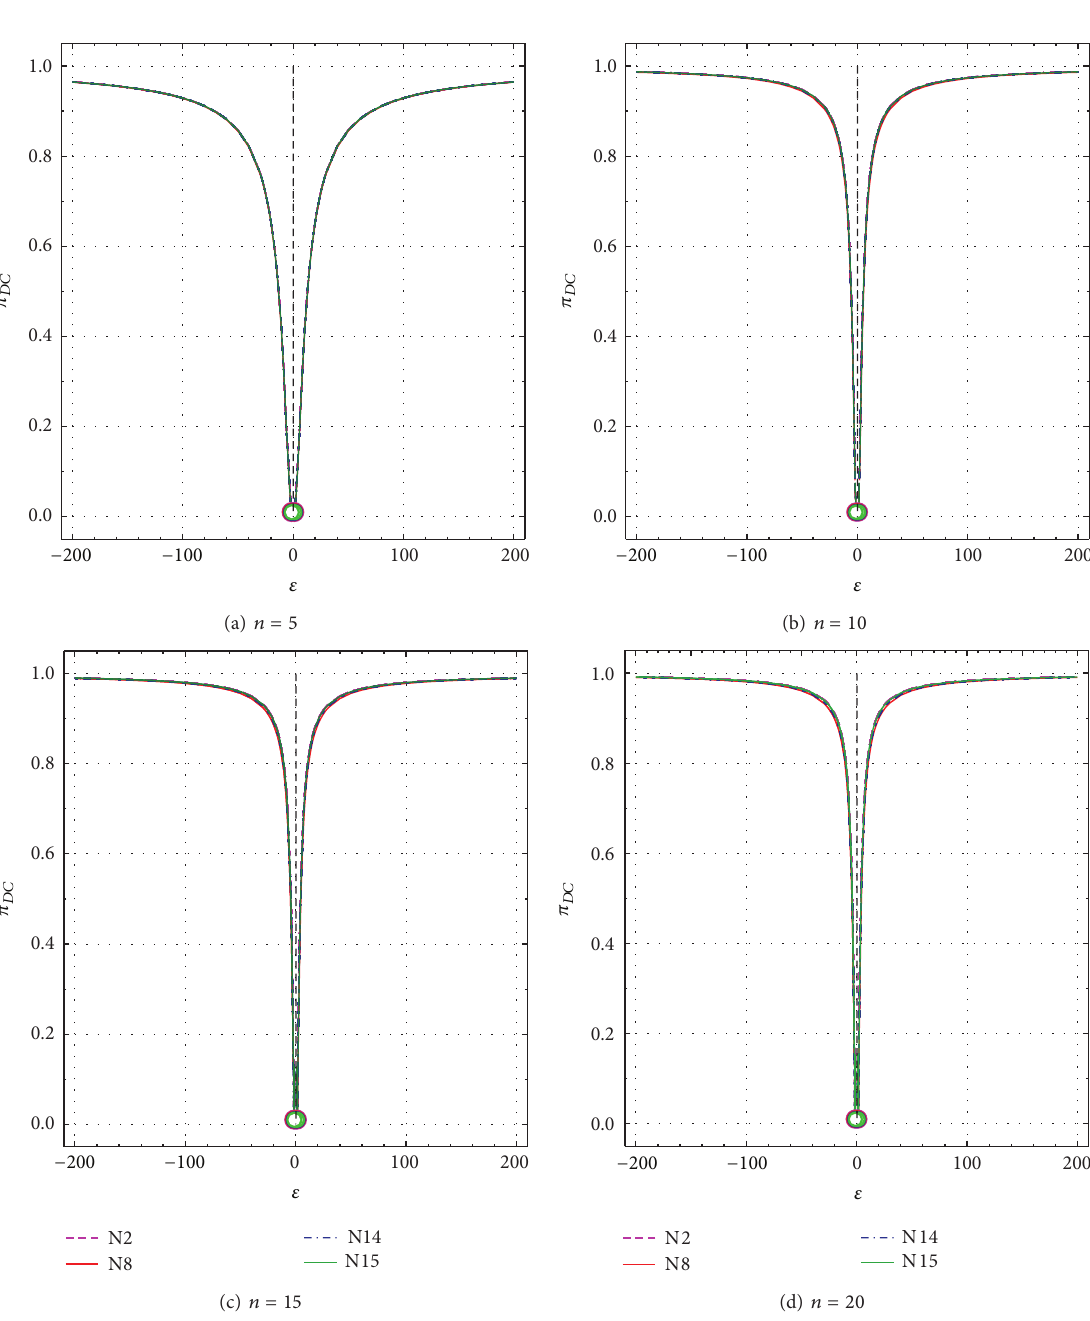
to − 15.5% for 𝛿 (Tables 3 and 4) or − 9.8% to − 11.5% for